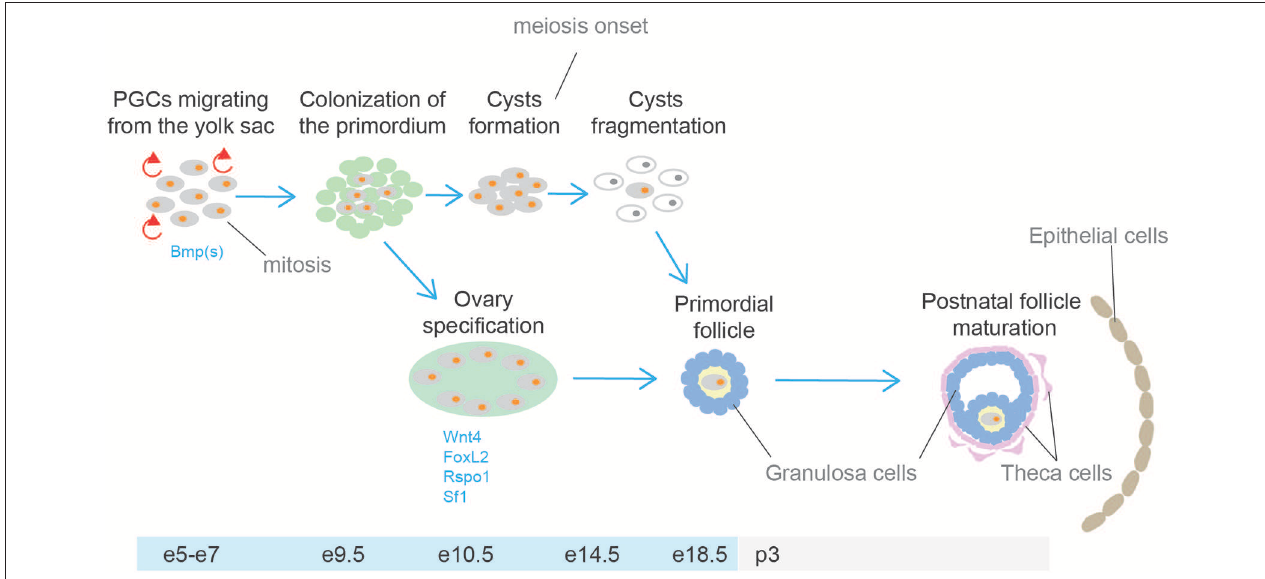
FIGURE 8 | Schematic representation of ovary development. Primordial germ cells (PGCs) colonize the gonadal primordium and undergo mitotic division with incomplete cytokinesis producing cysts. Subsequently, germ cell cysts undergo breakdown to produce primordial follicles, consisting of a single oocyte surrounded by pre-granulosa cells. During sexual maturation, primordial follicles develop further eventually becoming potential fertilizable eggs at sexual